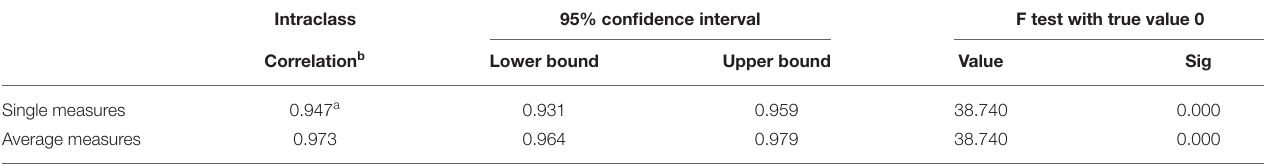
TABLE 3 | Intraclass Correlation